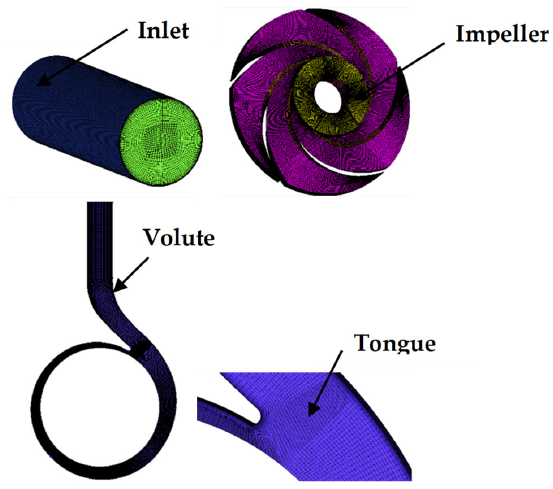
Figure 3. Detailed mesh view.